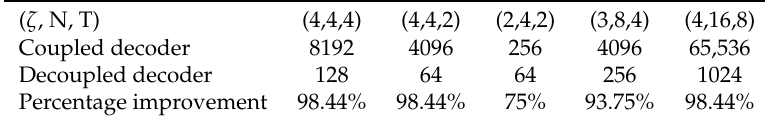
Table 1. Comparison between the computational complexity of the proposed decoupled decoder.